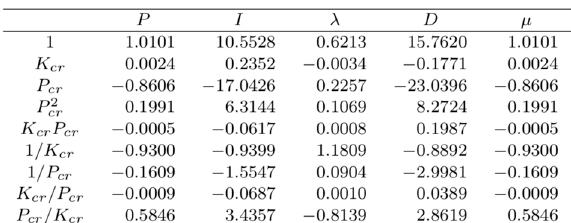
k p , I = k p /T i , D = k p T d ) [42].